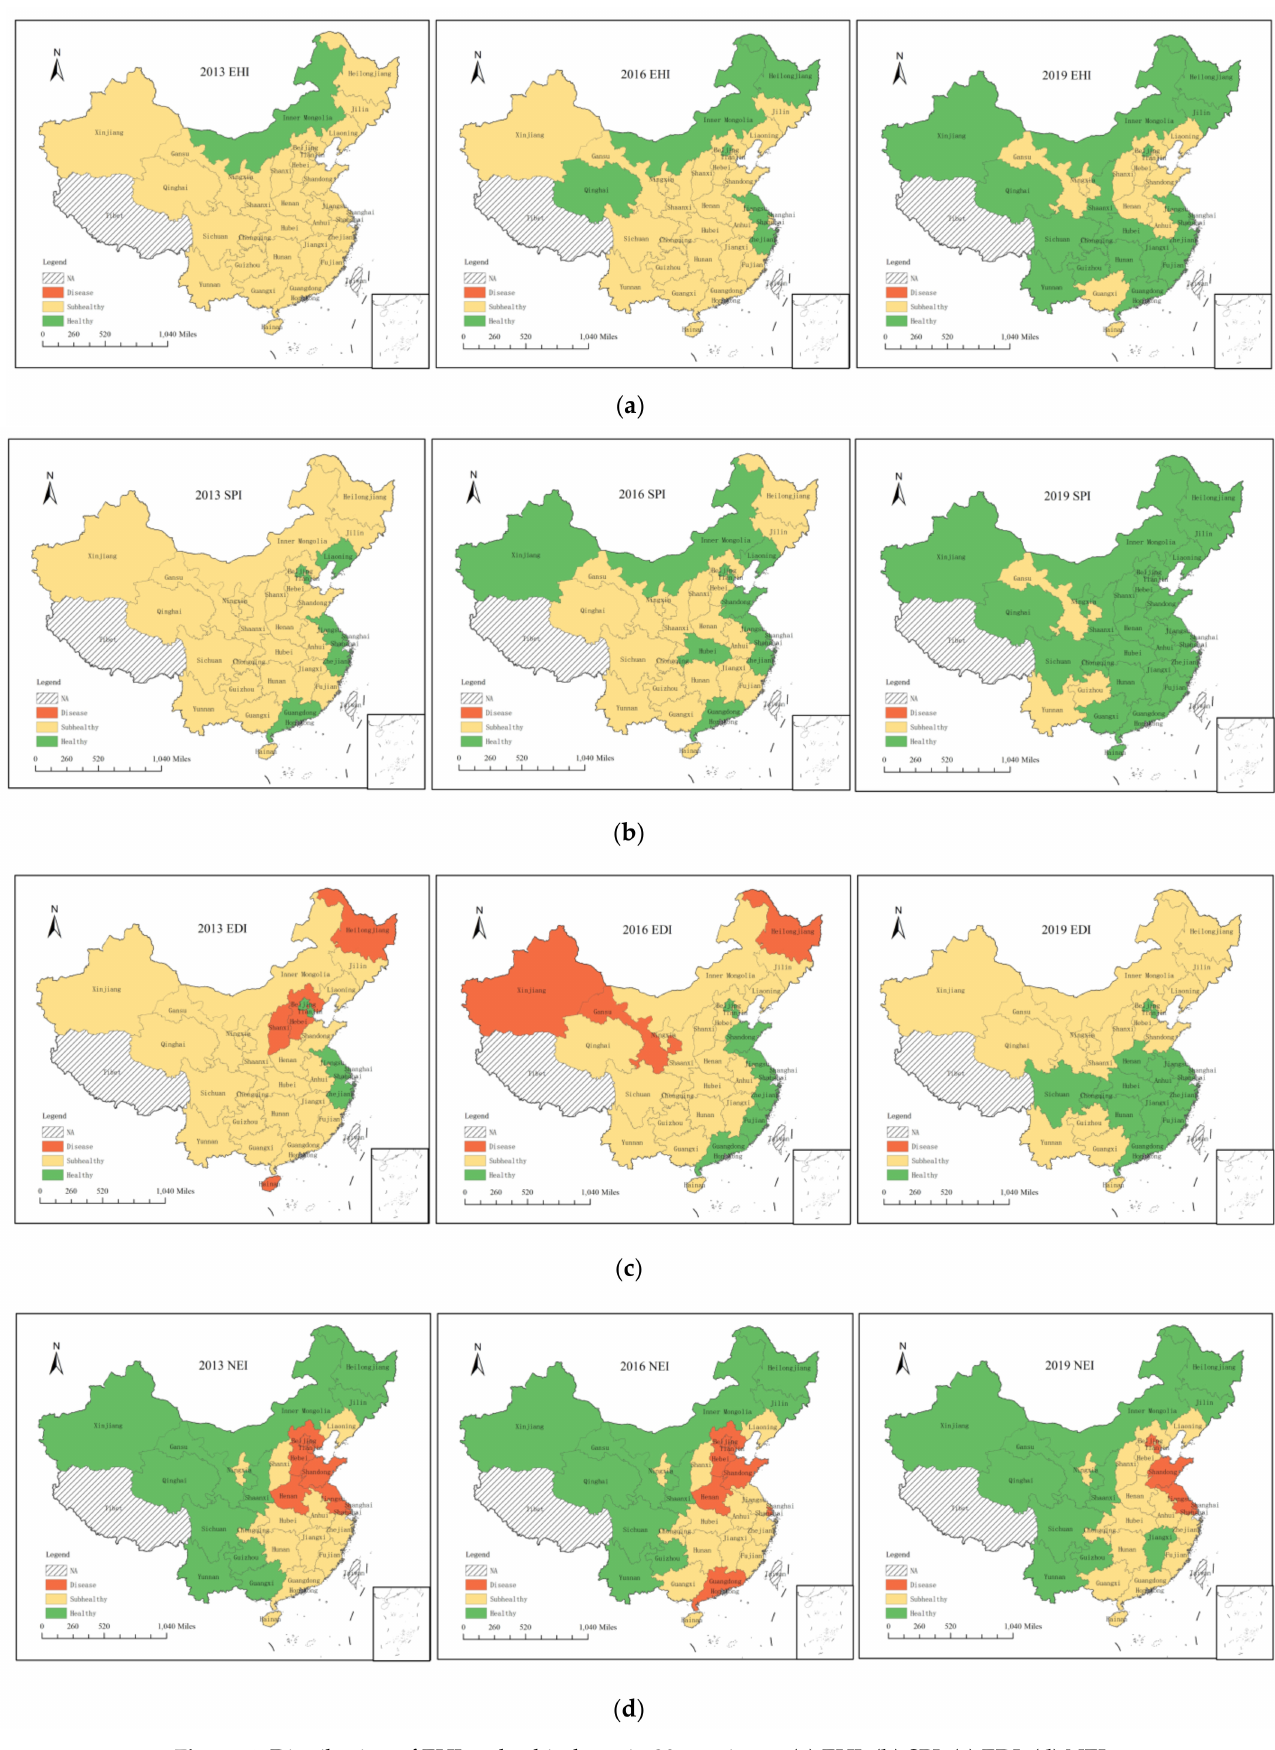
Figure 4. Distribution of EHI and subindexes in 30 provinces. ( a ) EHI; ( b ) SPI; ( c ) EDI; ( d )